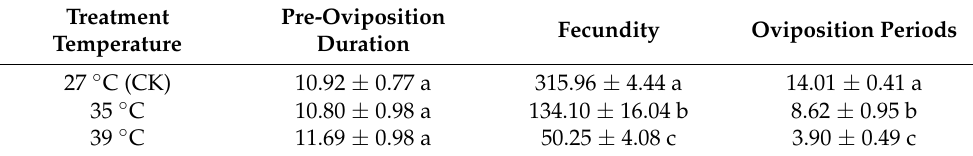
Table 4. Pre-oviposition duration, fecundity and oviposition periods of Leptinotarsa decemlineata after the adults were repeatedly exposed to different high temperatures (27 ◦ C, 35 ◦ C and 39 ◦ C). Data are expressed as mean ± SE. Data followed by the same letter in the same column are not significantly different ( p >